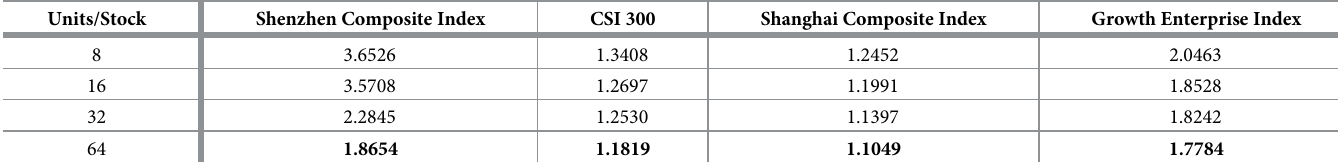
Table 6. MAPE value of index stocks in different number of units (%).